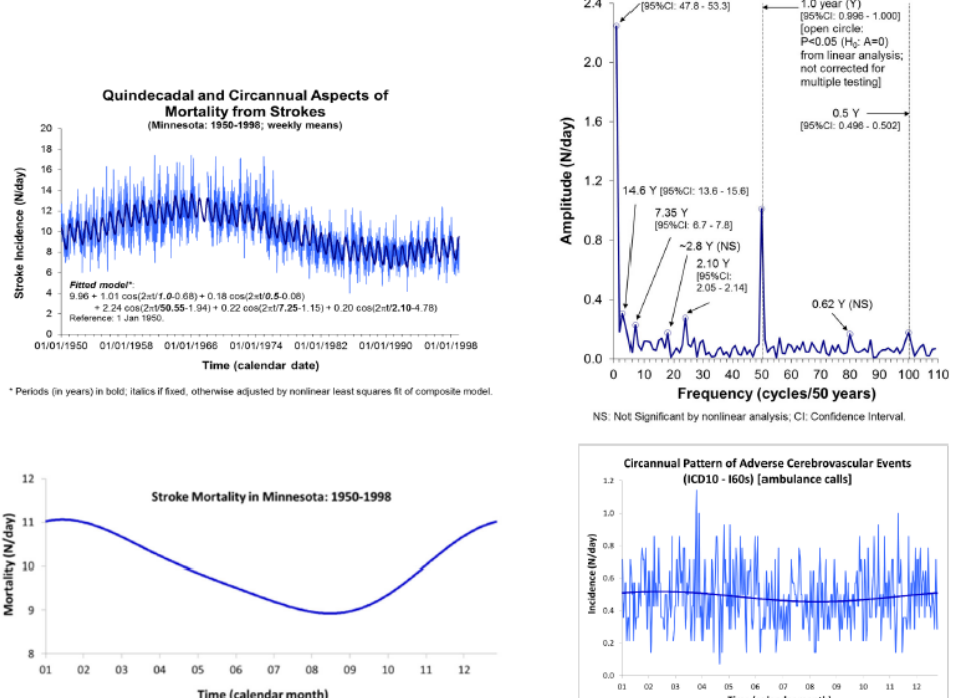
Figure 1. Time course of the incidence of stroke mortality in Minnesota during the span from 1950 to 1998, shown with 4-component model including a prominent circannual rhythm (top left). Least squares spectrum illustrates how prominent the circannual variation is, and indicates the presence of a weak second harmonic with a period of 6 months (top right). Reconstructed waveform of the circannual rhythm shows a peak incidence in winter (bottom left). Similar results are found for the incidence of all adverse cerebrovascular events in Khanty, Siberia, during the span from 2001 to 2014 ( N = 2485), based on much fewer data collected from calls for an ambulance (bottom right). © Halberg Chronobiology